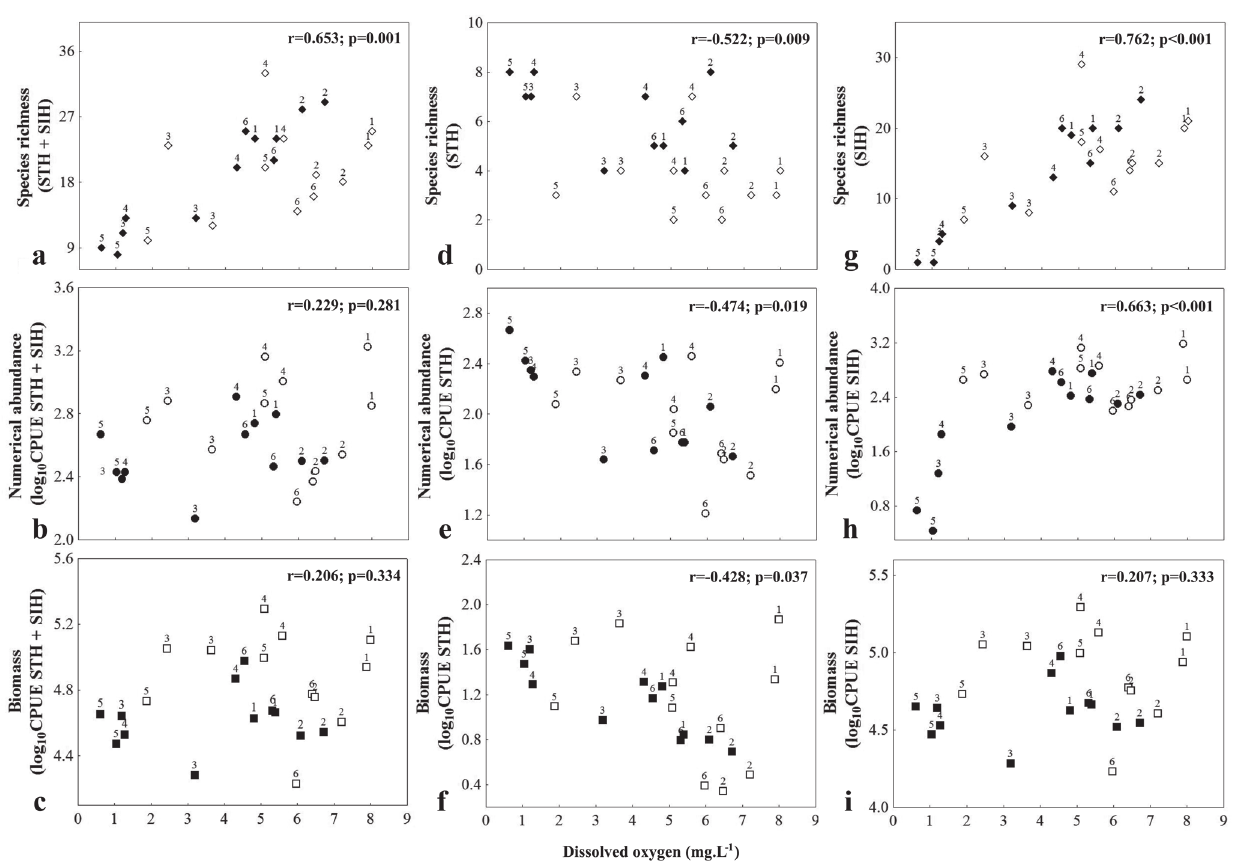
Fig. 6. Relationships between each assemblage attribute and dissolved oxygen, in years of short (white) and moderate floods (black). Attributes where either calculated for the entire fish assemblage (STH+SIH) ( a-c ) and for the subsets of STH ( d-f ) and SIH ( g-i ). Numbers 1-6 are codes of the sampling stations (see Fig.